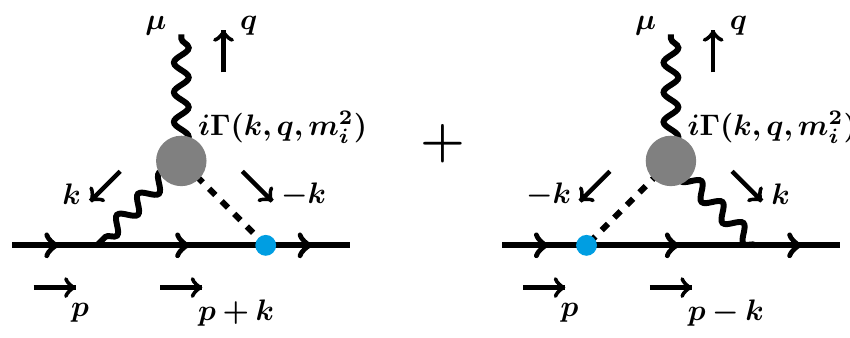
) . To obtain the i